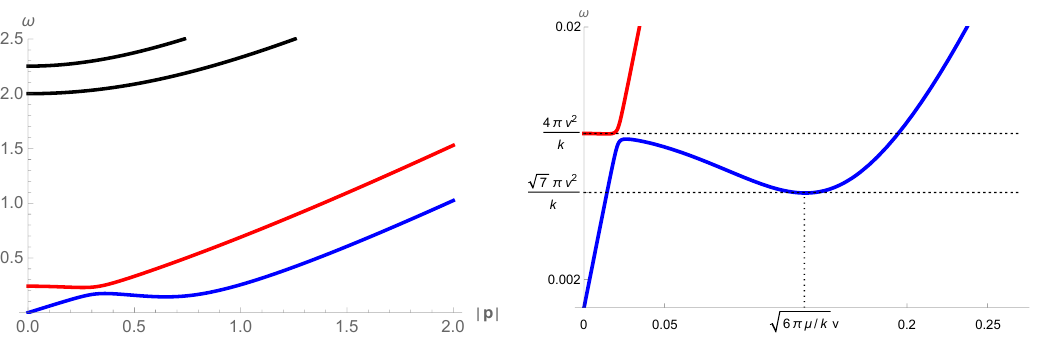
Figure 4 . Left: the spectrum for m = 0 with ~ (cid:22) = (cid:25)(cid:22) B =g 4 k = (cid:25)= 20. Right: the two lightest states, including the phonon-roton branch (blue) with ~ (cid:22) = (cid:25)= 500. The dotted lines indicate the large- k limiting values of the roton maximum and minimum.